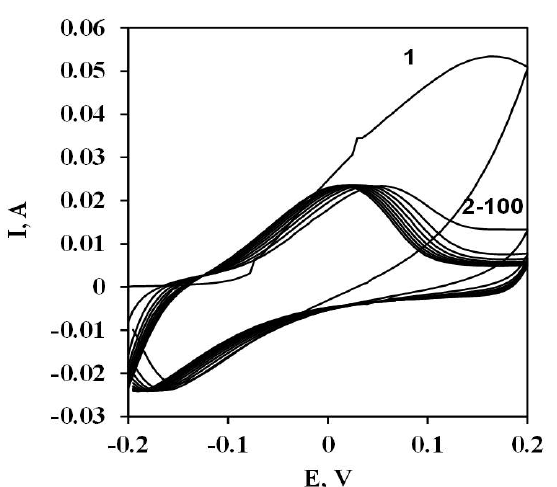
Figure 7. Cyclic voltammograms of Co(OH) 20AL3 mesh in 0.1 mol L -1 NaOH solution. The